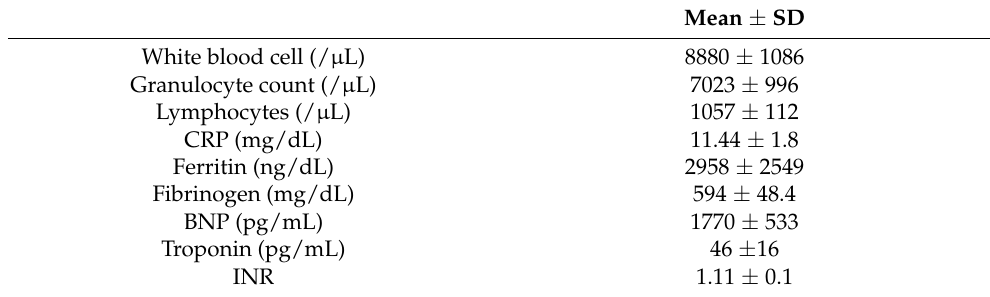
Table 2. Laboratory findings.